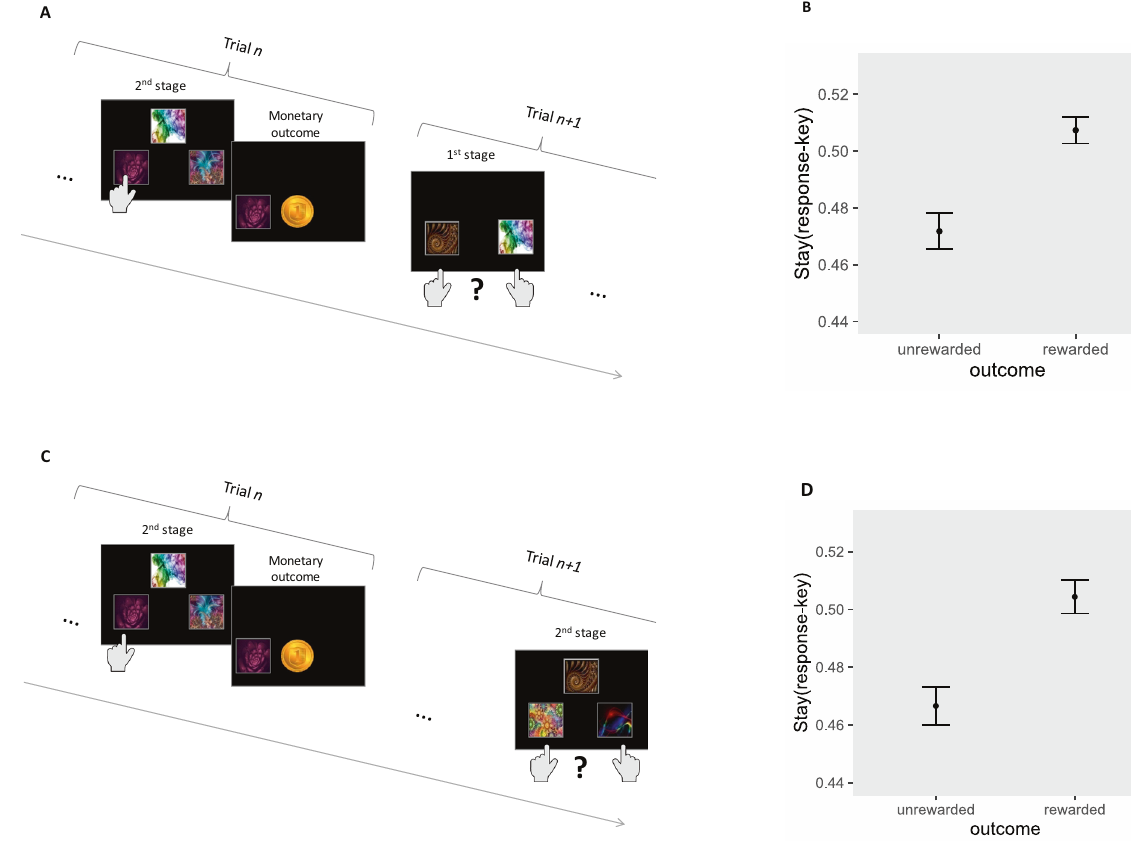
Fig. 3 Outcome-irrelevant learning. The fi gure illustrates two sequential trial analyses (previously reported in Shahar et al.), demonstrating outcome-irrelevant value learning. These analyses examined a tendency to repeat a response key selection from trial n to trial n + 1, as a function of reward. A , B First-stage score — In this analysis, we show the in fl uence of reward delivery on a tendency to re-select a response key during the fi rst stage of the n + 1 trial, which was previously selected in the second stage of the n trial. For example, if the individual selected a fractal with a left response key press in the second stage of trial n , the left response key is more/less likely to be selected in the fi rst stage of the following trial as a function of the reward/unrewarded outcome in trial n , respectively, as shown in panel ( B ). C , D Second-stage score I — In this analysis, we demonstrate the in fl uence of reward delivery on a tendency to re-select a response key in the second stage of the n + 1 trial, which was previously selected during the second stage of the n trial. This analysis included only trials in which a different pair of fractals was offered in the n and n + 1 trial. For example, if the individual selected a fractal with a left response key press in the second stage of trial n , the left response key is more/less likely to be selected in the second stage of the following trial as a function of reward/unrewarded outcome in trial n , as shown in panel ( D ) (for second-stage score II, see Supplementary